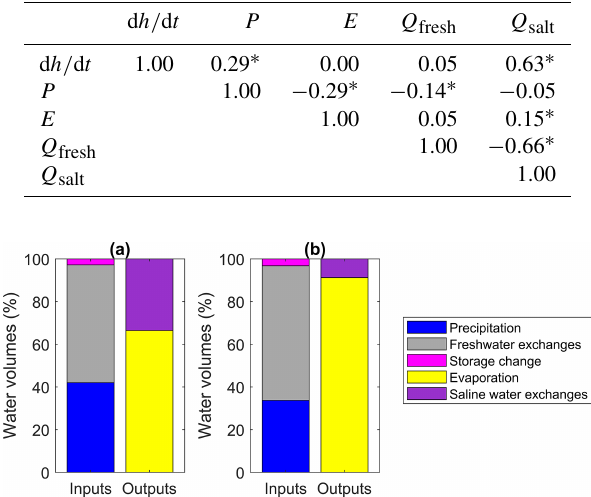
Table 3. Pearson correlation coefficients between pairs of hydro- logic fluxes (or change in storage), as calculated with Eqs. (10) and (11) at the daily timescale (asterisks ( ∗ ) indicate significant cor- relations, p < 0 . 001). d h/ d t